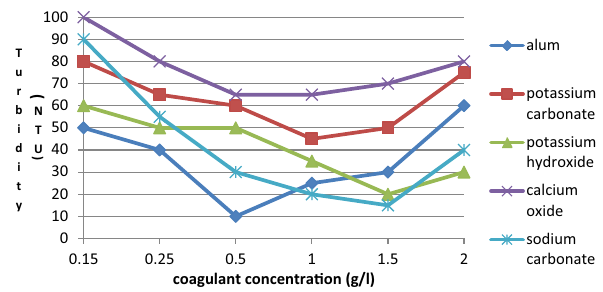
Fig. 1 Turbidity at varying doses of coagulants (pH 7)